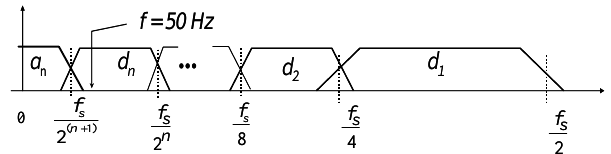
Fig. 3. Filtering process performed by the